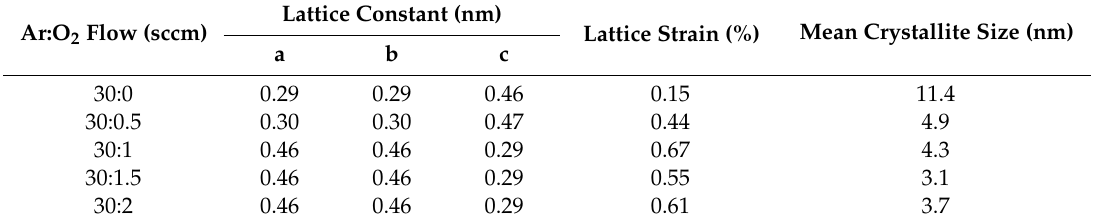
Figure 3. ( a ) Experimental GI-XRD patterns (black curve) of the investigated samples and the corresponding simulated curves (red curve). The letters “r” and “a” symbolize the rutile and anatase phases and the sharp peak at ~51 ◦ for the middle spectrum (Ar:O 2 = 30:1.5) is caused by the Si substrate. ( b ) Enhancement of ( a ) in the 2 θ range of 23 ◦ –29 ◦ for the TiO 2 thin films. Table 3. Structural parameters for Ti and TiO 2 : lattice constant, lattice strain and mean crystallite size.